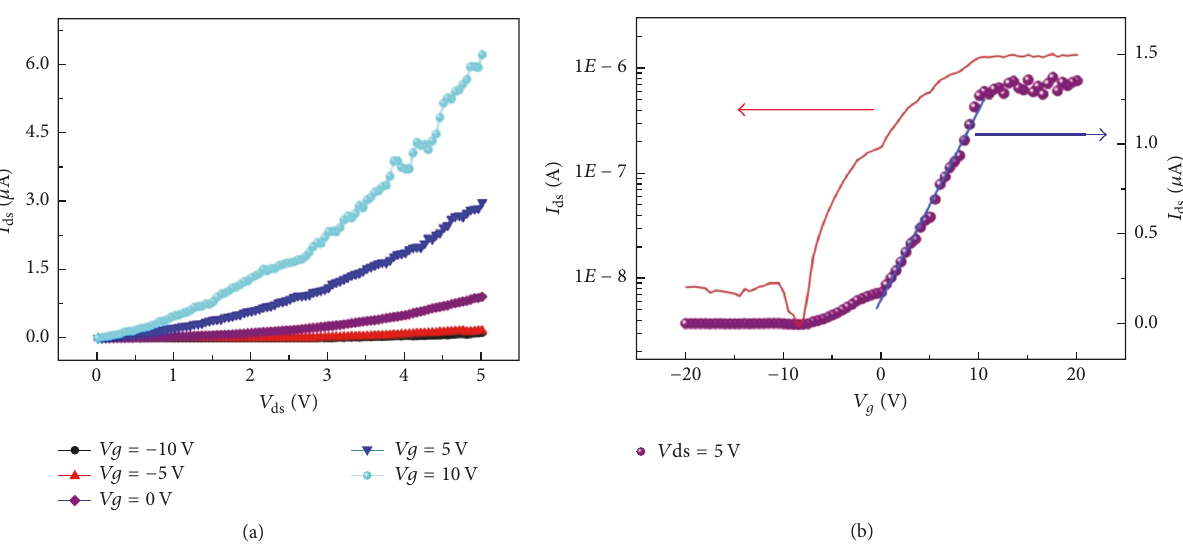
Figure 4: FETs characterization of few-layer MoS 2 film. (a) Transport characteristics at different 𝑉 𝑔 . (b) Transfer curves of MoS 2 thin films in logarithmic and linear